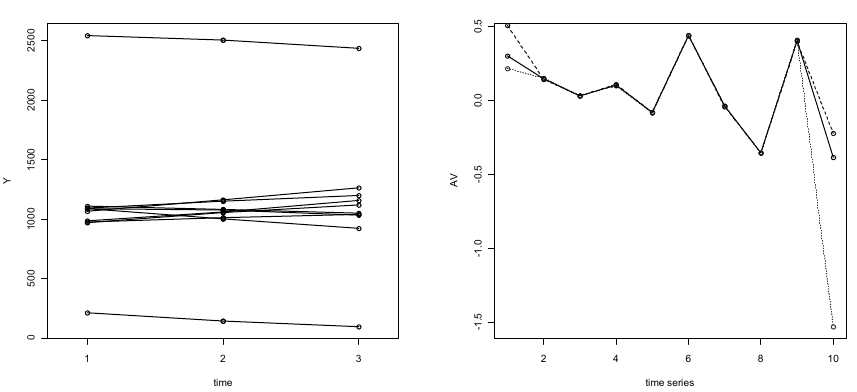
Figure 7 – Example of ten approximately lin- ear time series at time 1, 2 and 3.